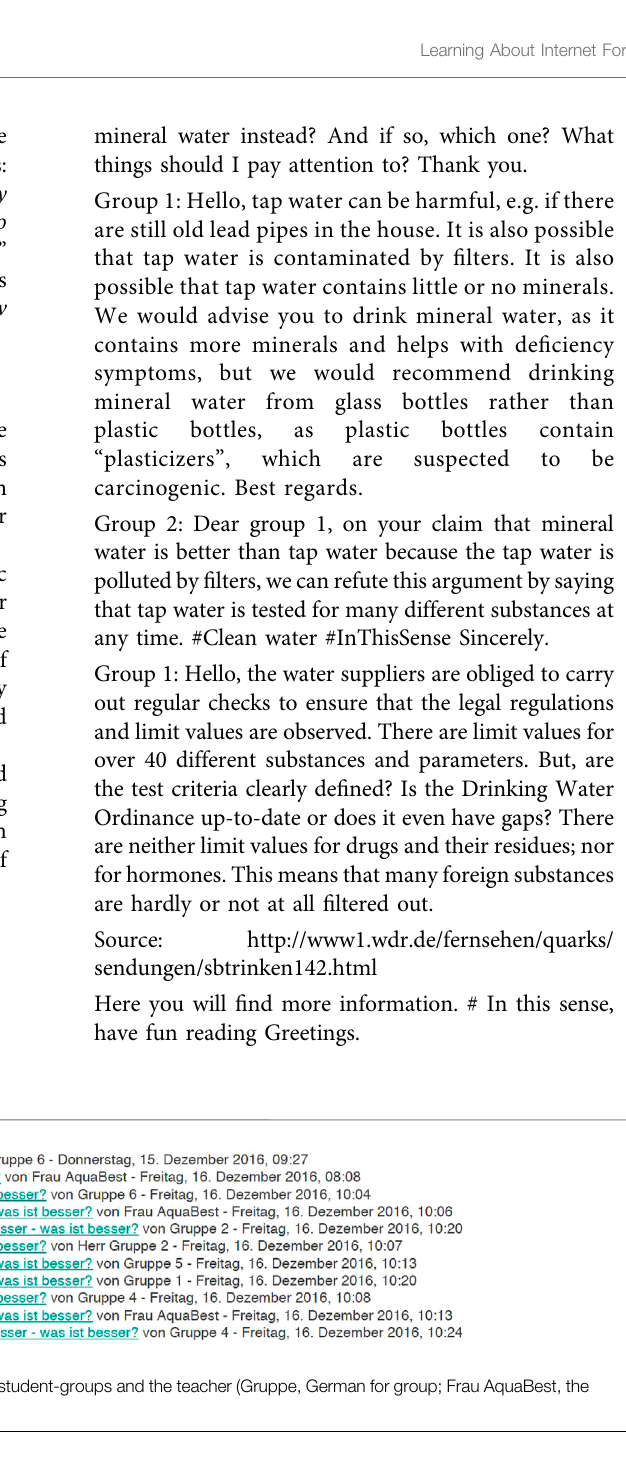
TABLE 3 | Distribution of forum posts. Learning